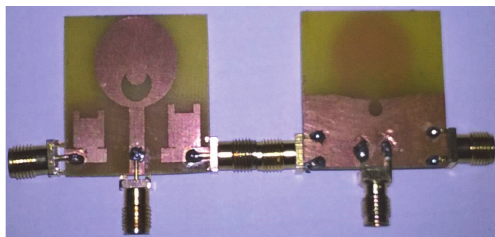
Figure 11: Top and bottom views of the fabricated prototype.